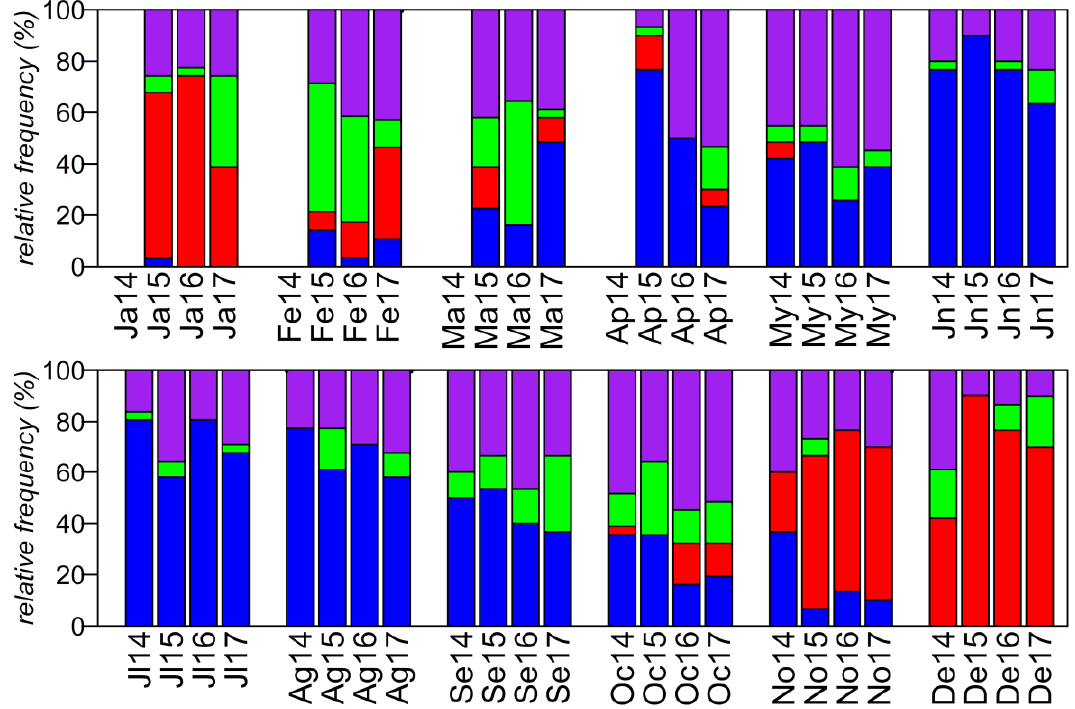
Figure 13. Interannual cycle of the relative frequency for different trajectory clusters. Cluster A (Blue), cluster B (red), cluster C (green), and cluster D (brown).